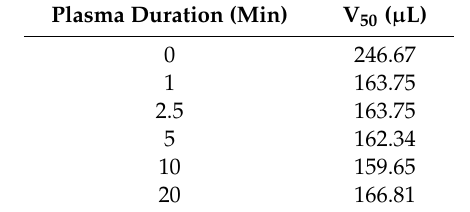
Table 2. E ff ect of plasma duration on calculated pCD pre-polymer solution volume needed for complete coverage of half of tested PP well